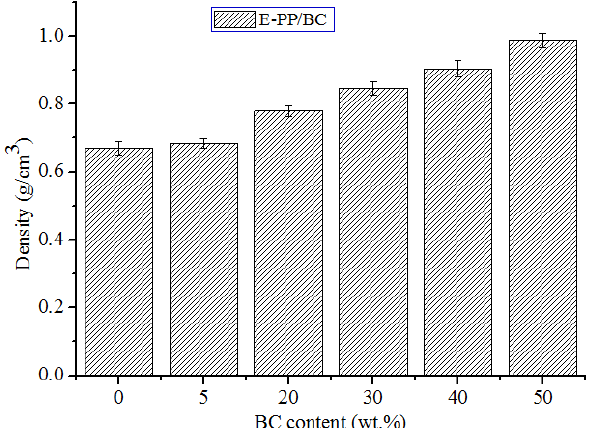
Figure 6. Change in the density of the foamed E-PP/BC composites with different BC content.